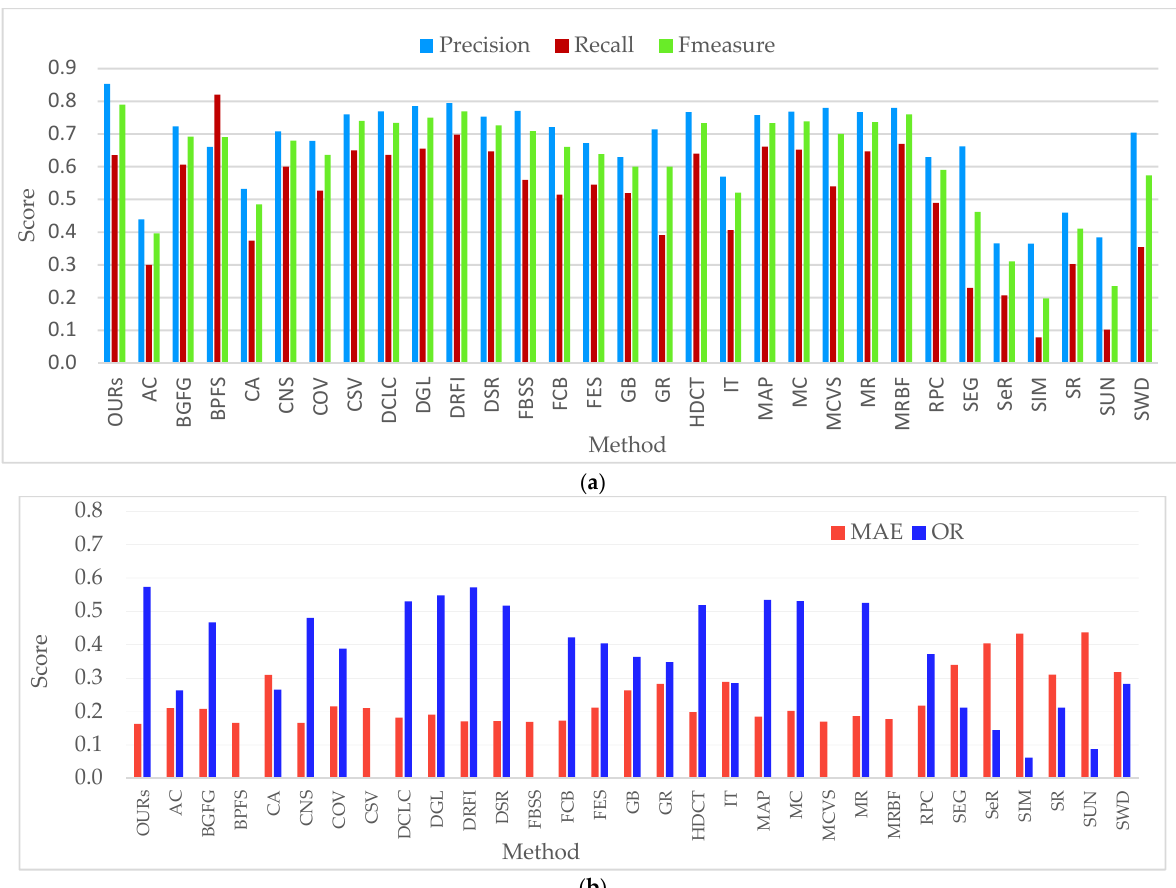
Figure 11. ( a ) F-measure; ( b ) MAE and OR on ECSSD dataset. Table 4. Comparison with deep learning methods in terms of F-measure and MAE on ECSSD dataset. Method